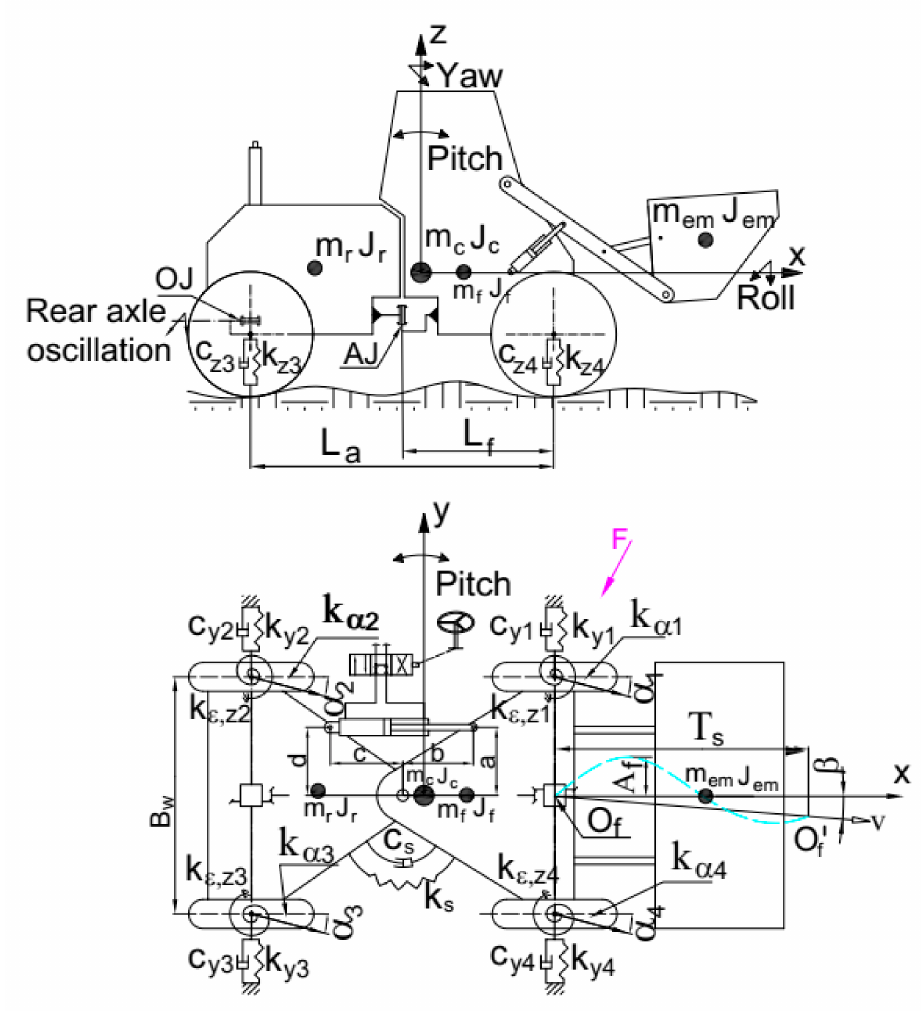
Figure 3. Main factors influencing the directional stability of an articulated frame steer wheeled